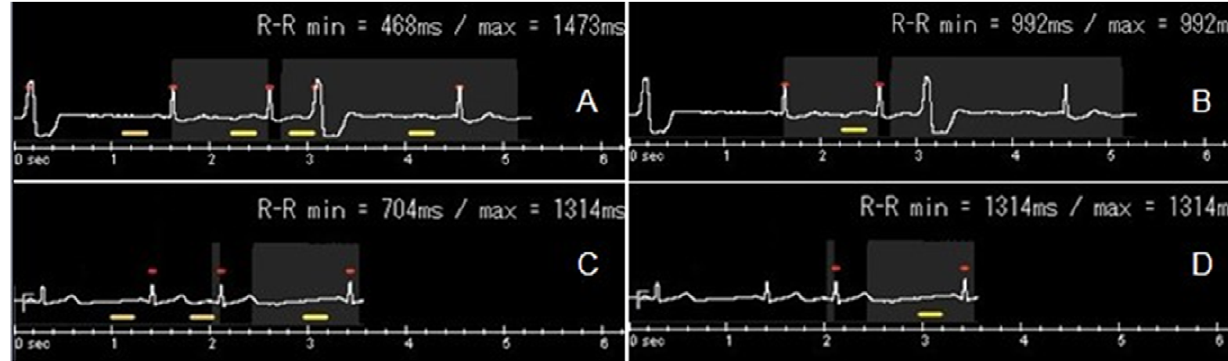
Figure 3. Two patients with ventricular premature beats. Figure A shows that heart rate is 71 bpm, 2-beat scanning is adopted, and acquisition is at 30–80% of R-R interval. A premature beat is encountered at the second beat during scanning. The scanning does not stop, and continuously scans the next R-R interval. Figure C shows the heart rate to be 55 bpm, 1-beat scanning is adopted, and acquisition at is 70–80% of R-R interval. Scanning is stopped immediately when a premature beat in encountered, and the scan is resumed at the next normal cardiac cycle. Figures B and D show the ECG-edit of A and C respectively.